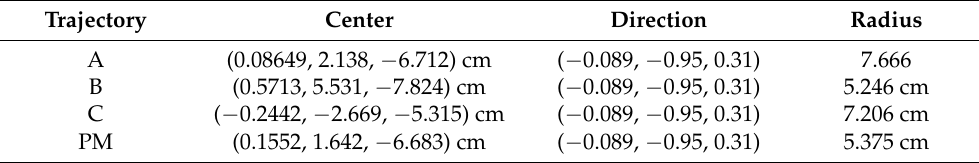
Table 6. TC axis circle fitting.